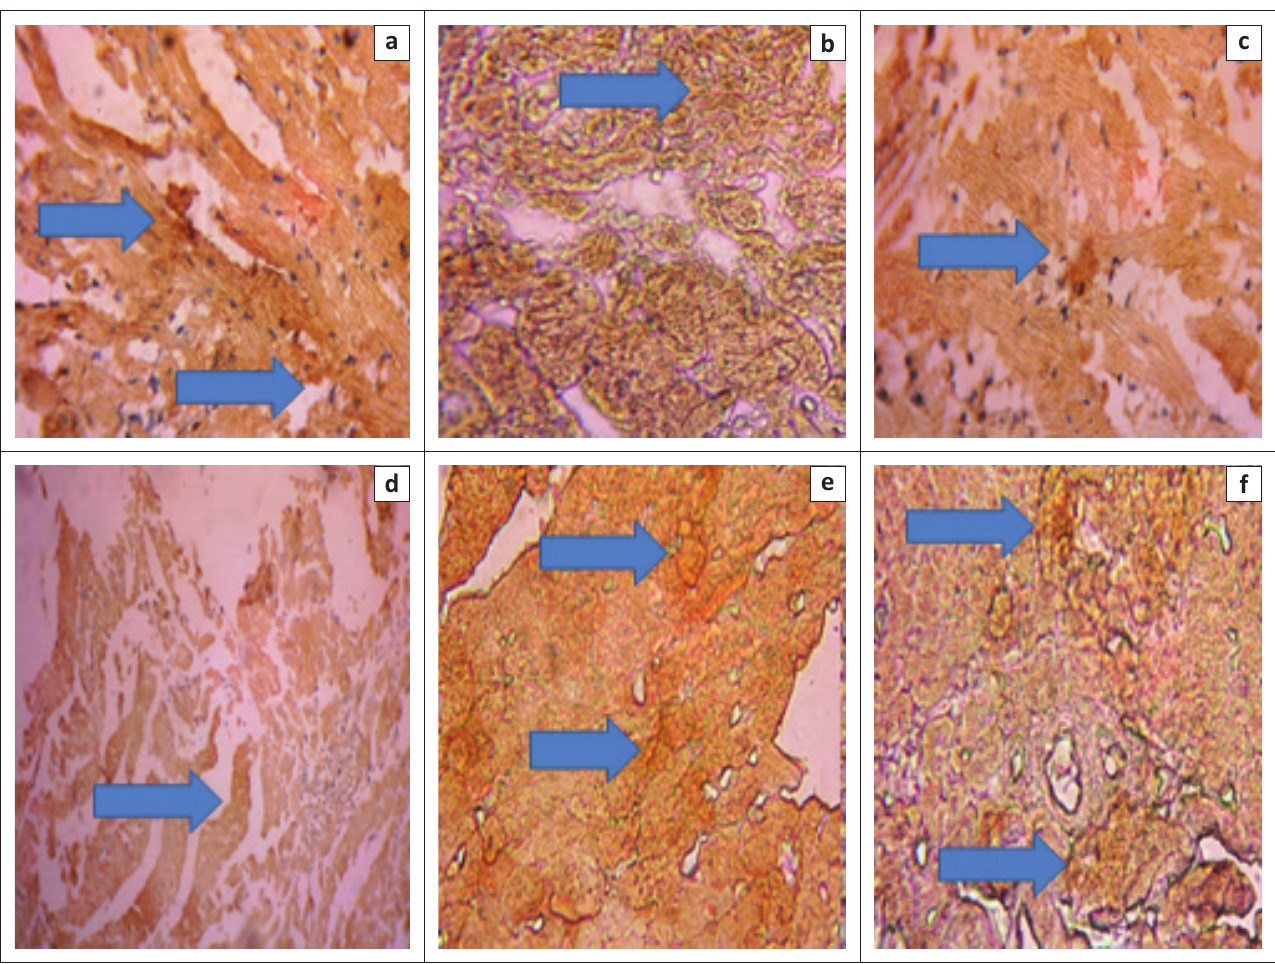
FIGURE 16: Immunohistochemistry of interleukin-10 in heart of isoproterenol-induced myocardial infarction